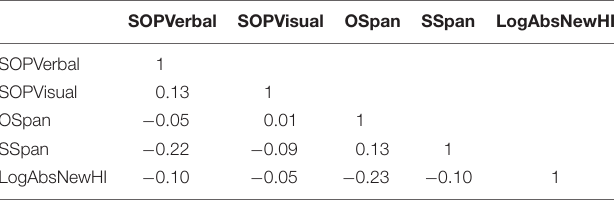
TABLE 5 | Correlation Matrix of SOPVerbal, SOPVisual, OSpan, SSpan, and LogAbsNewHI for Chinese Group. SOPVerbal SOPVisual OSpan SSpan